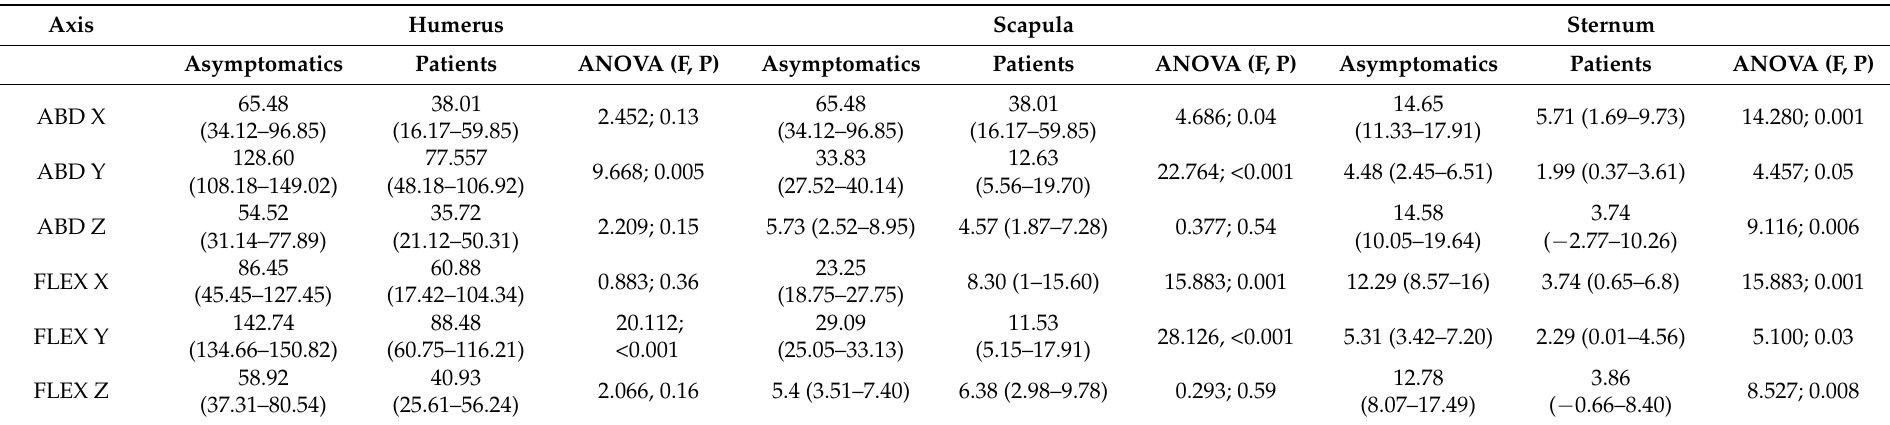
Table 2. Mean (95% CI) sensor angular mobility ( ◦ ) from each axis in abduction and flexion movement.